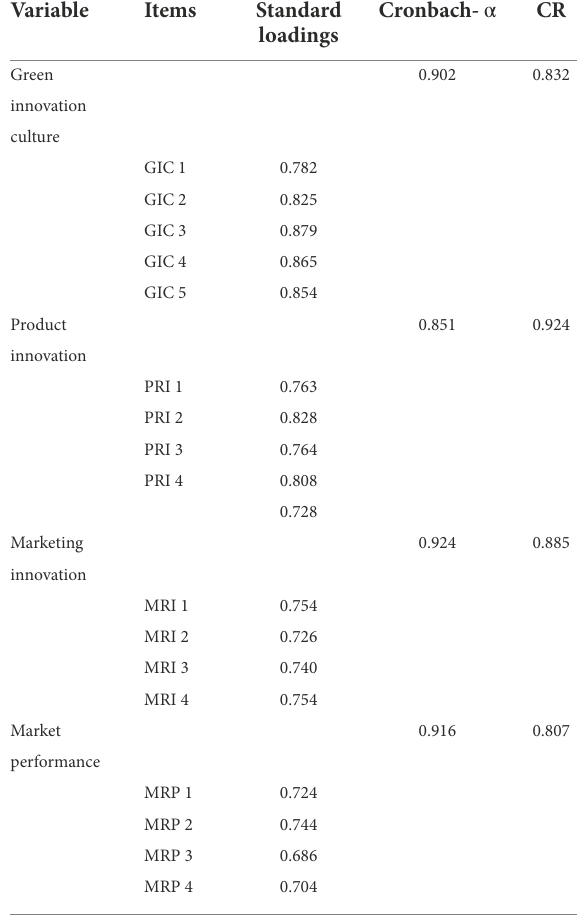
TABLE 3 Factor loading and discriminant